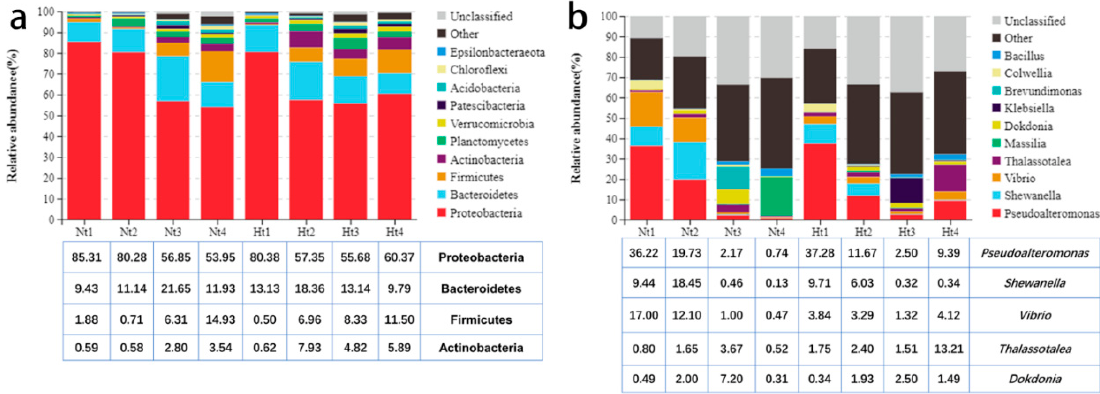
Figure 4. Epibacterial community composition of G. vermiculophylla . ( a) , ( b) , The epibacterial distri- bution at phylum and genus level, respectively. Nt: normal seawater temperature; Ht: 3 °C higher temperature; 1, 2, 3, and 4 represent May, June, July, and August, respectively.